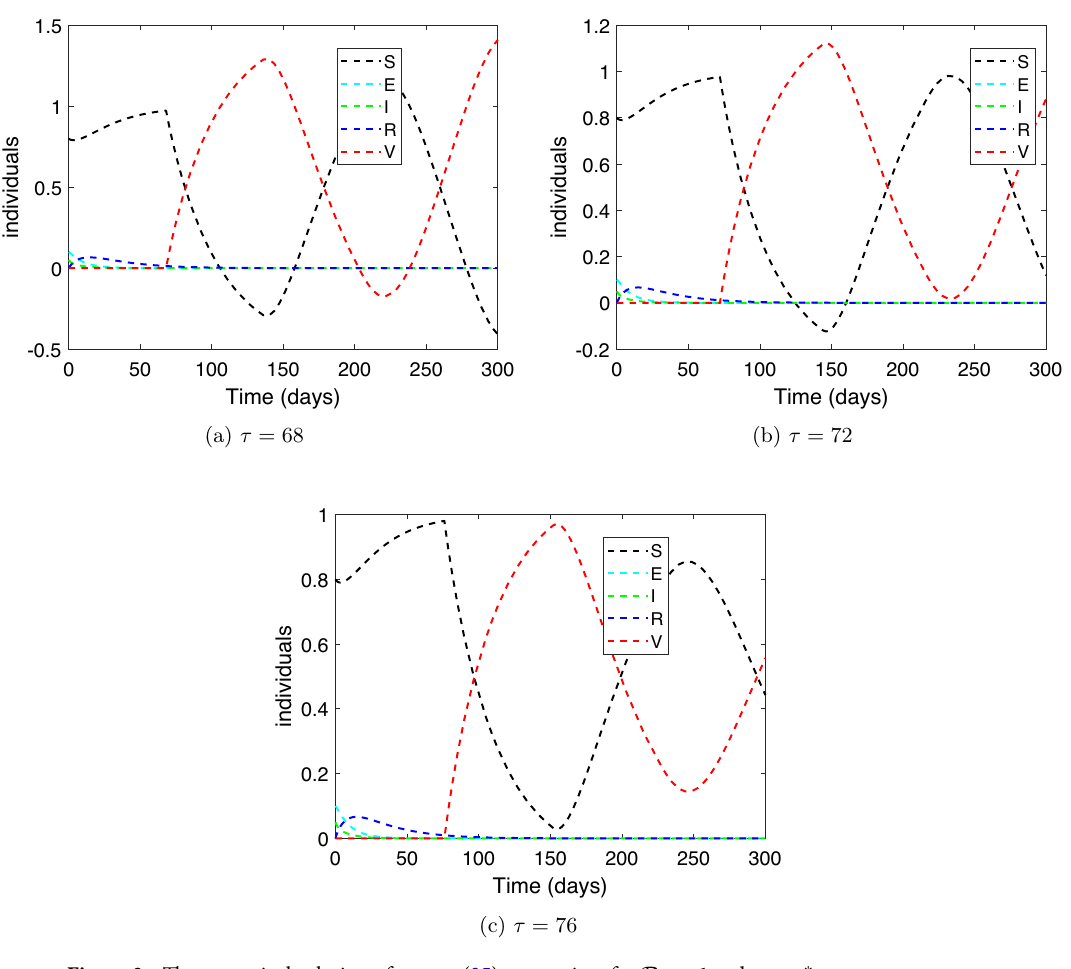
Figure 3. The numerical solution of system (25) versus time for R c < 1 and τ < τ ∗